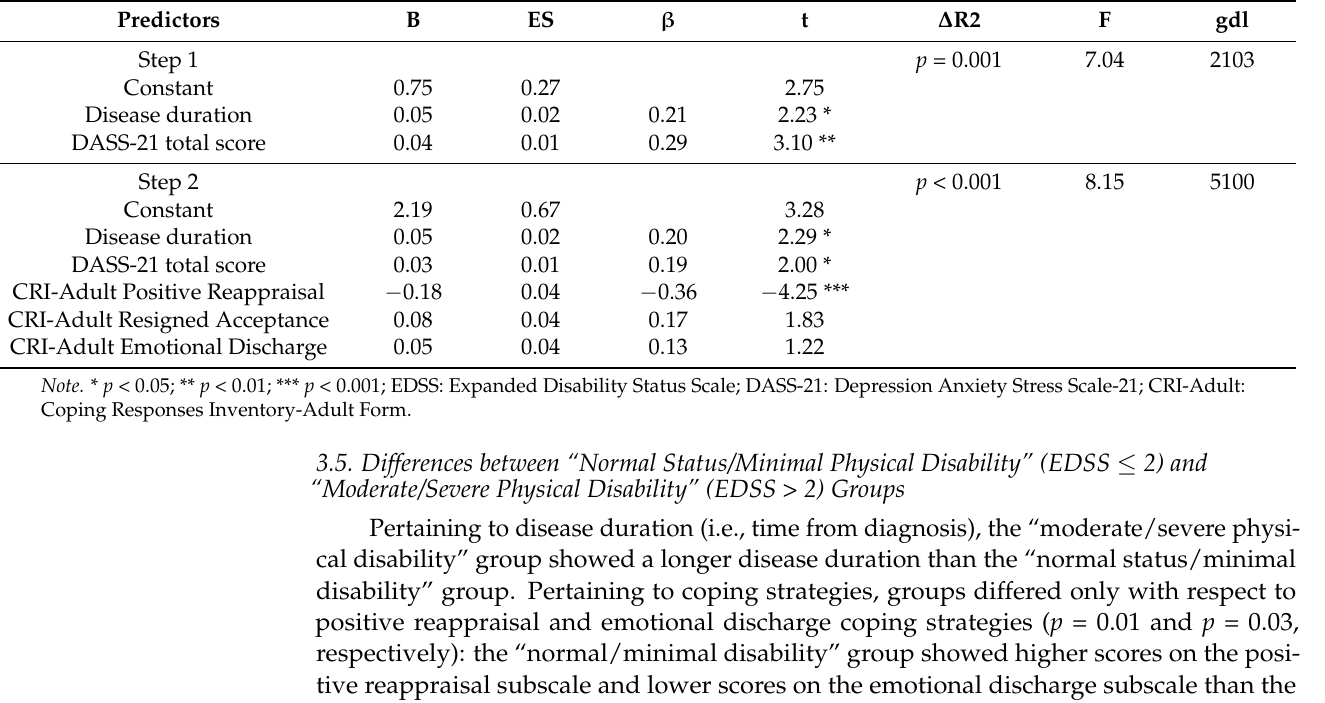
Table 4. Results of multiple regression analysis predicting EDSS.